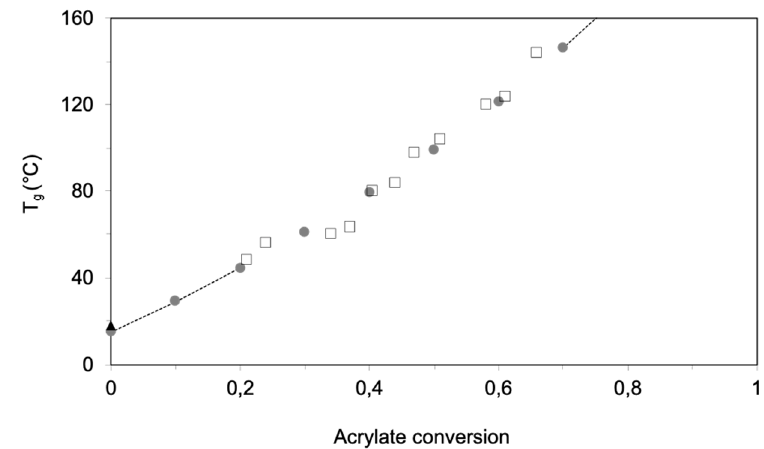
Figure 6. Plot of the T g (tan δ maximum in DMA spectrogram) as a function of acrylate conversion for EB-cured EPAC materials (for various EB doses, dose rates, and dose increments). The dotted line corresponds the simulation based on DiBenedetto’s model.